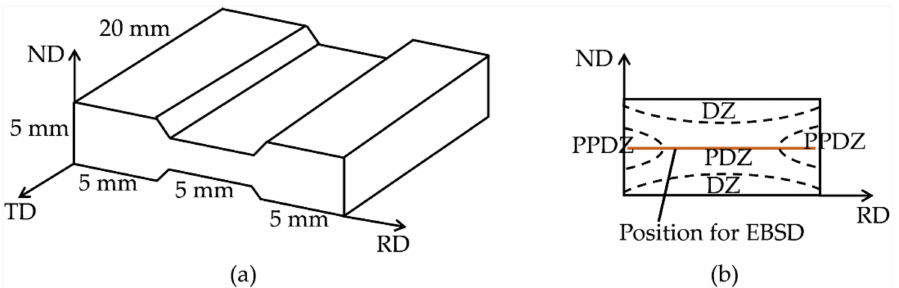
Figure 1. ( a ) The geometry of the plane-strain specimen, ( b ) diagram of the characteristic region of the effective strain distribution in the RD-ND section of the deformation zone.